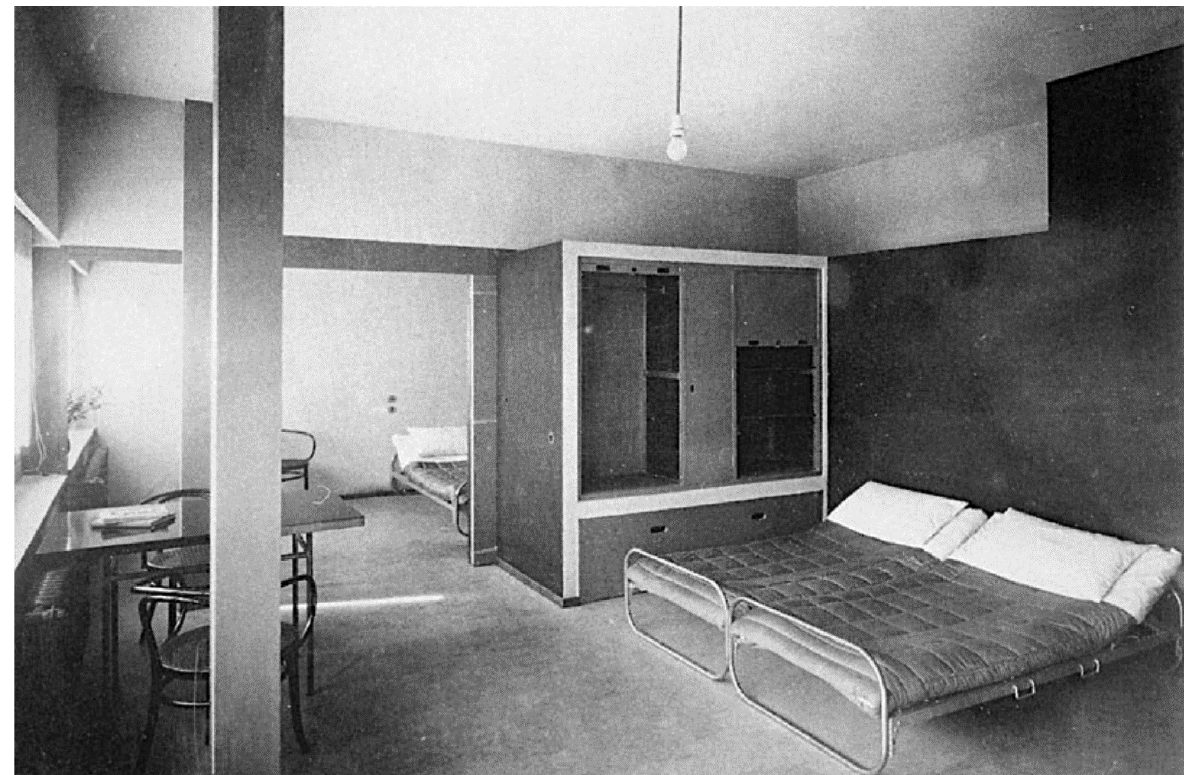
Figure 5. Le Corbusier, two-storey (duplex) housing units at Weissenhof, night layout, 1927. Source: Le Corbusier